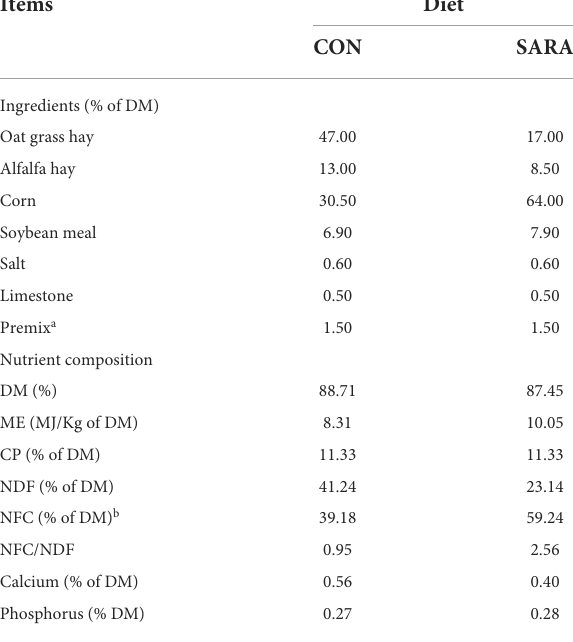
TABLE 2 The composition of artificial saliva buffers for rumen fermentation in vitro